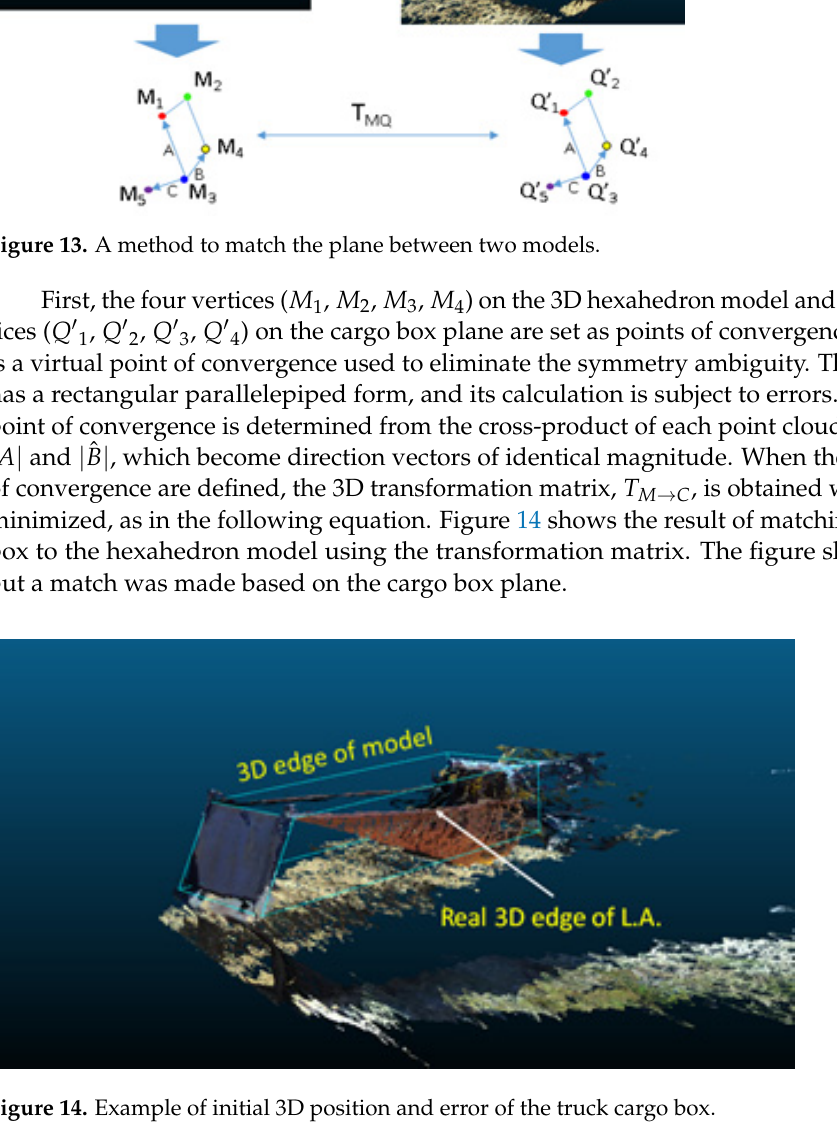
Figure 12. Example of detecting four vertices of a door.